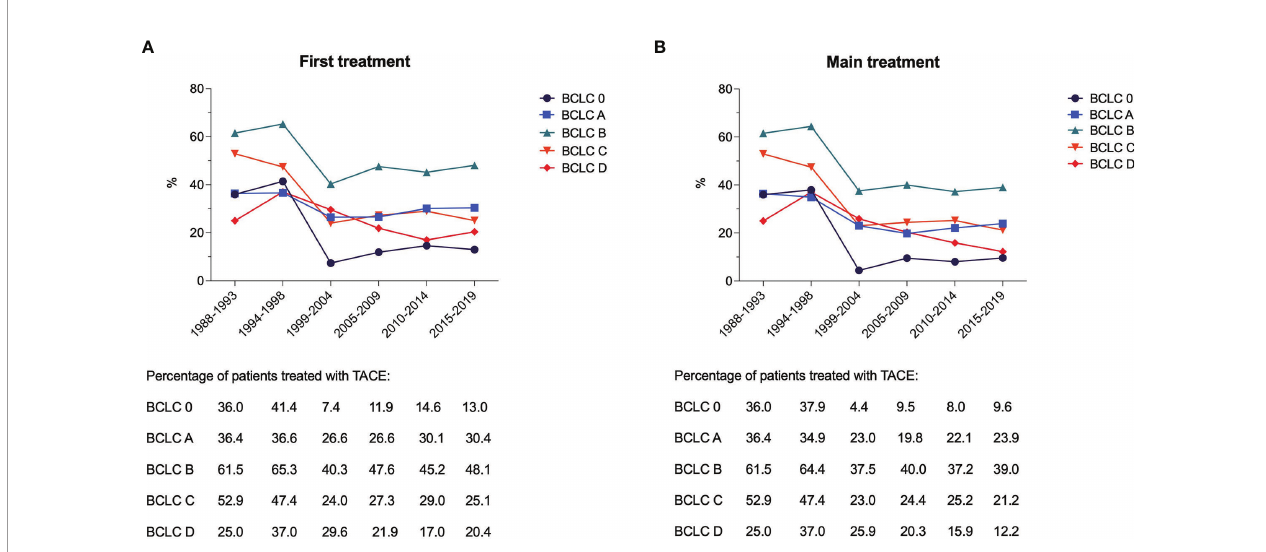
FIGURE 2 | Proportion of patients treated with TACE as fi rst (A) and main (B) treatment in the six time periods considered, according to the BCLC